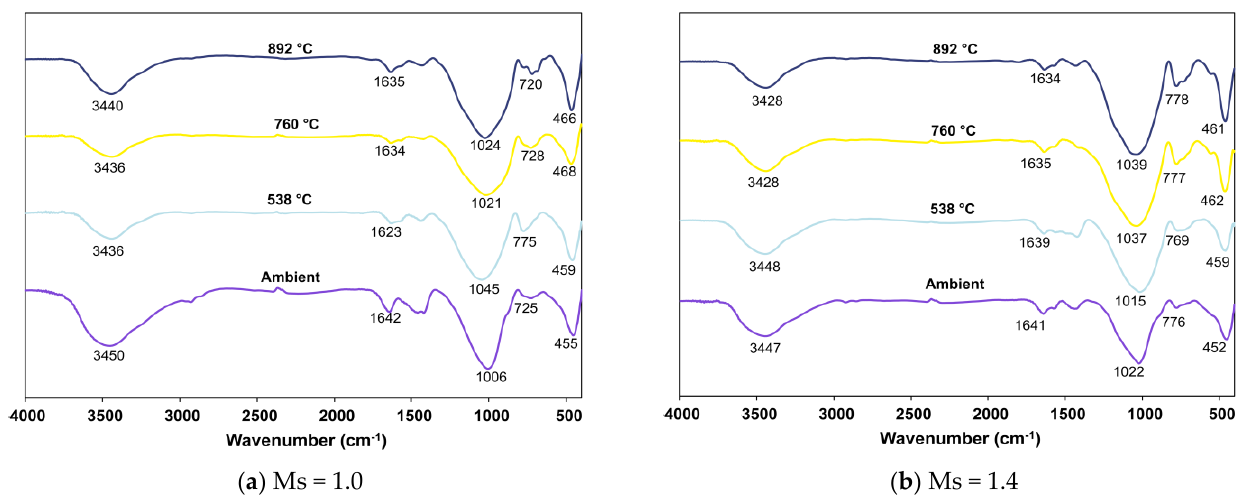
Figure 10. FTIR spectra of FS 0P on exposure to elevated temperature.